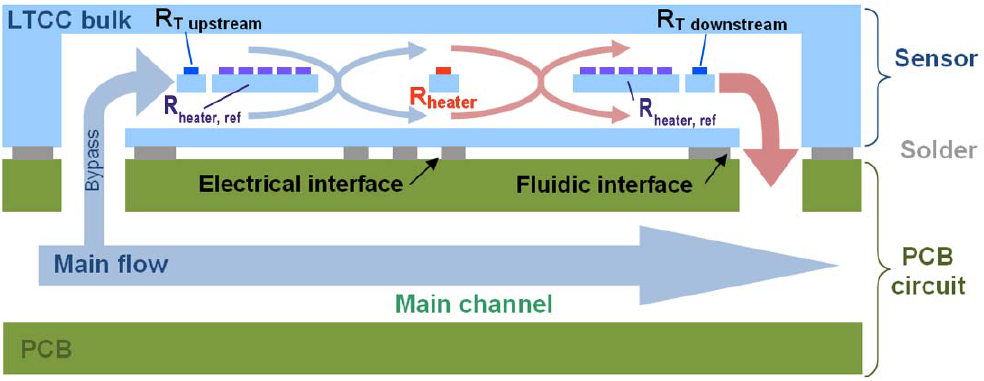
Figure 6. Schematic view of the flow + temperature sensor sections when mounted on a fluidic PCB, depicting the bypass and